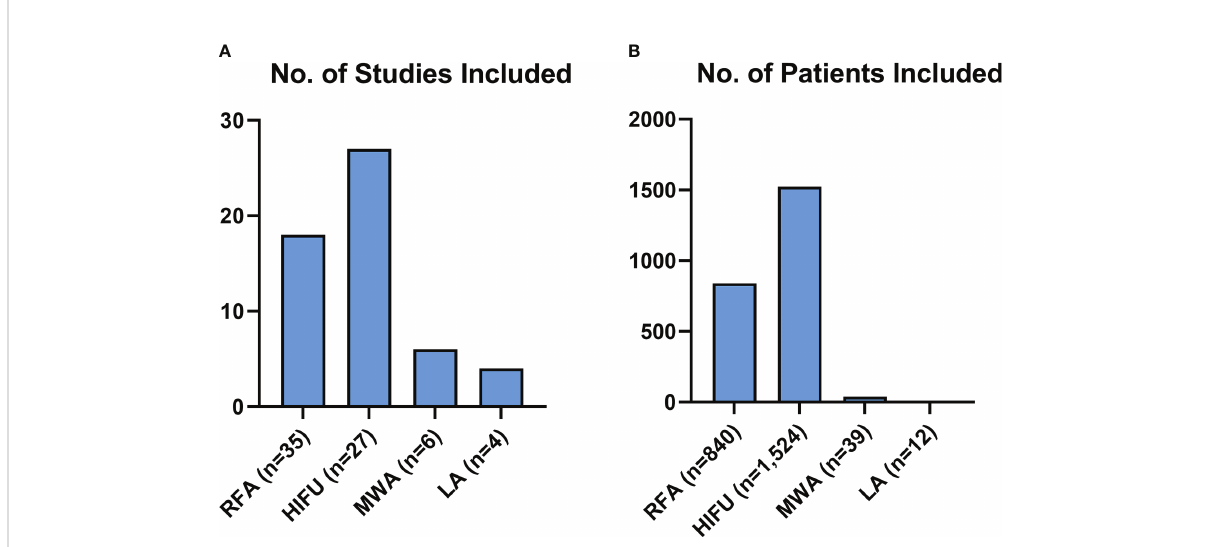
FIGURE 3 Review Population Graphs. Figure 3 describes the makeup of all the subjects of this review for each modality, both in terms of studies (A) and patients included (B) .